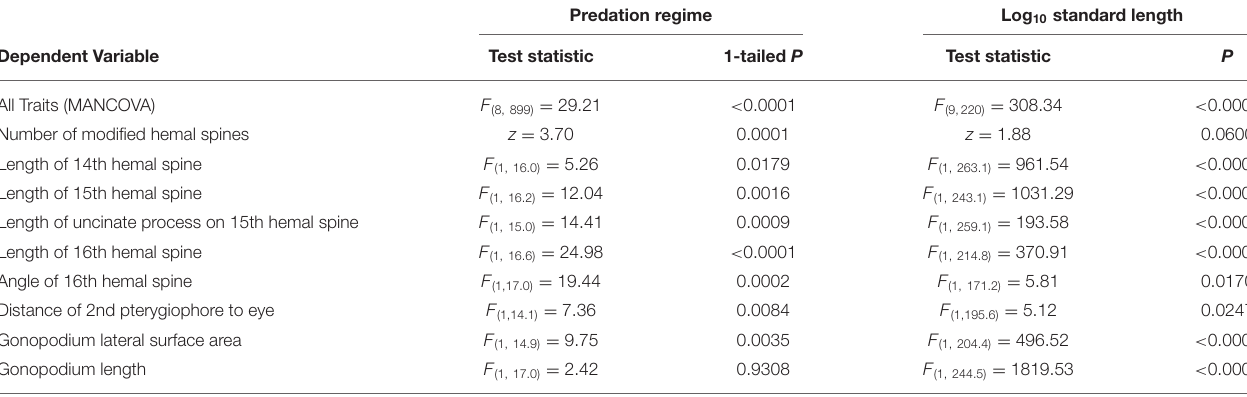
TABLE 1 | Statistical results examining variation in gonopodial-complex traits across predation regimes in Bahamas mosquitofish (see statistical details in text). Predation